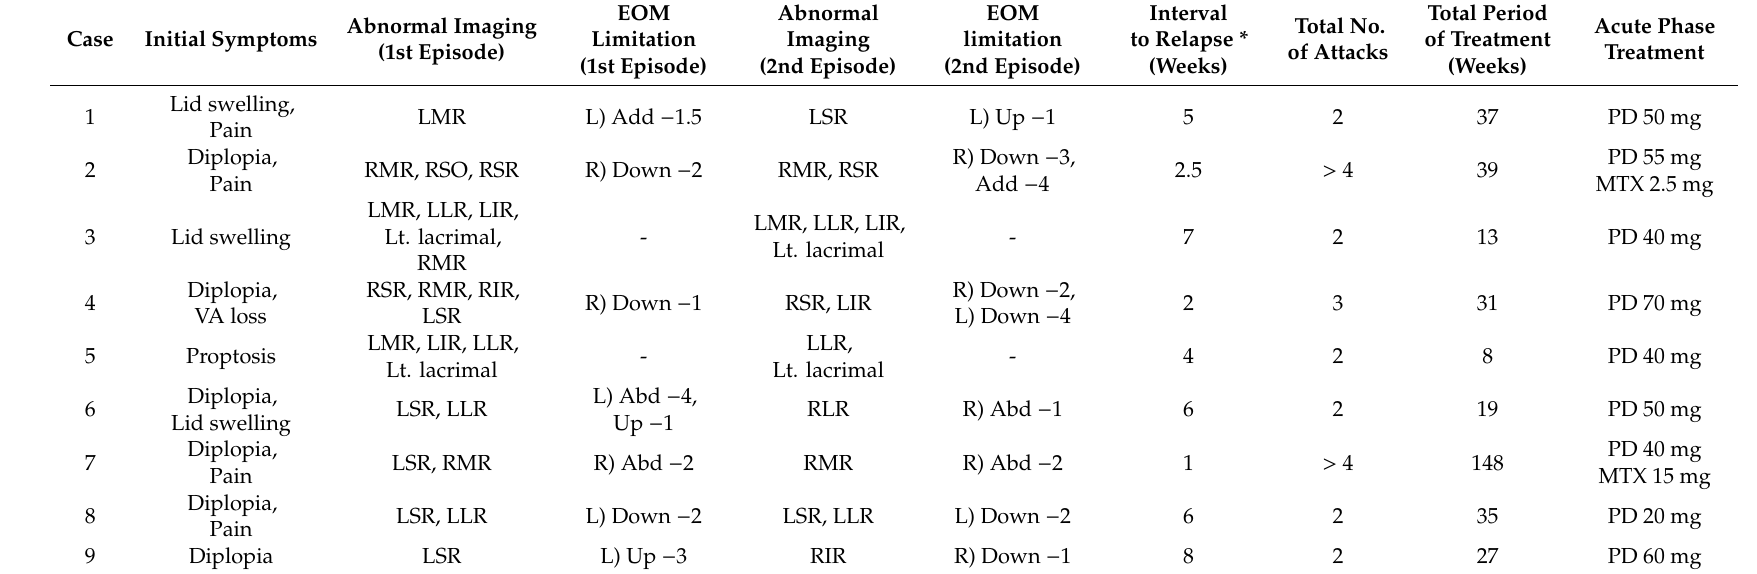
Table 3. Clinical characteristics of 9 patients with relapsing orbital